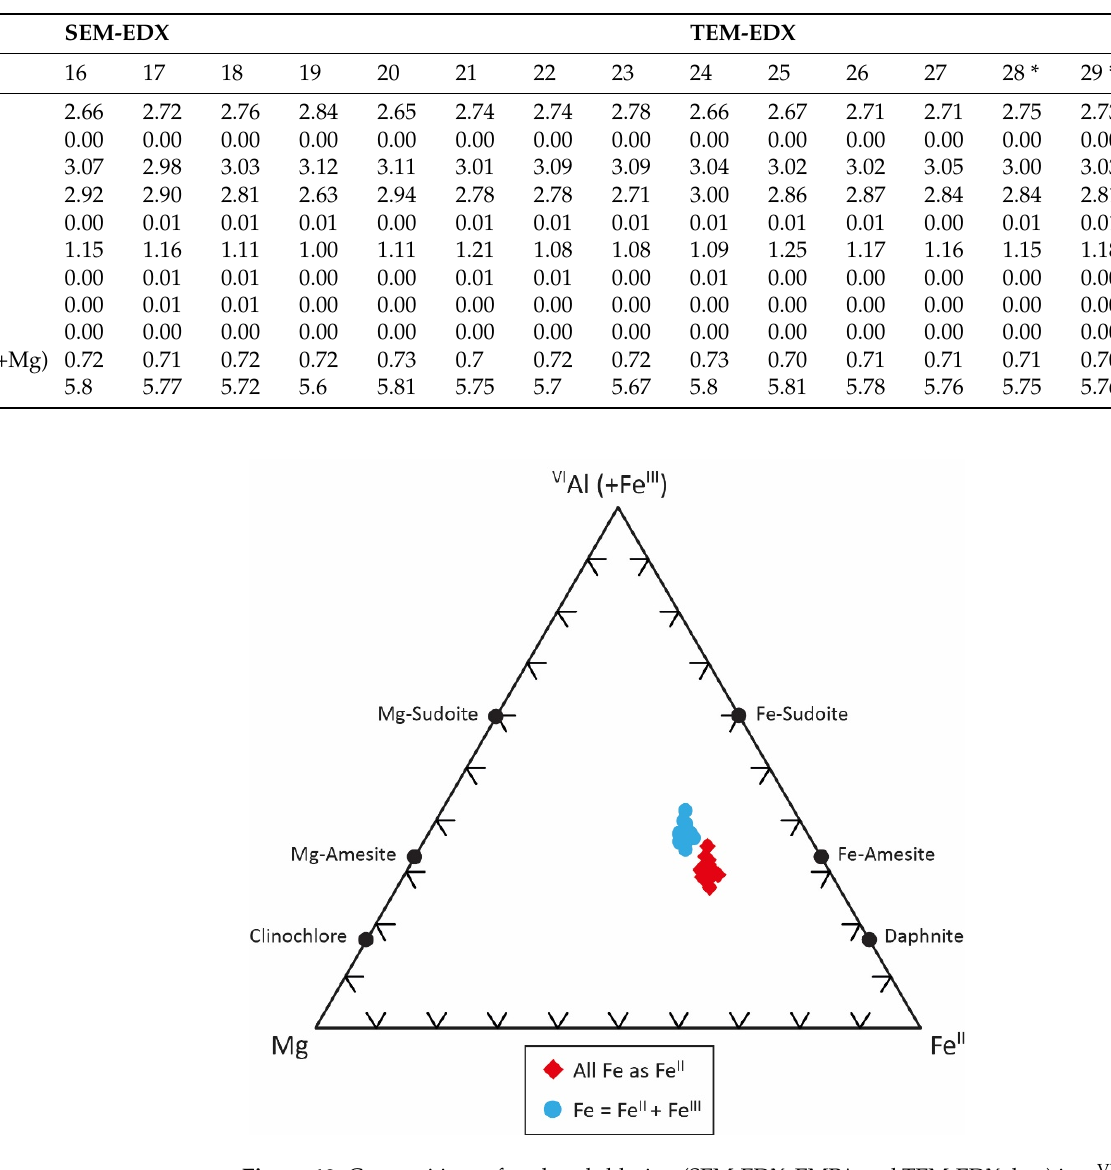
Figure 10. Compositions of analysed chlorites (SEM-EDX, EMPA and TEM-EDX data) in a VI Al-Mg-Fe II ternary diagram. Chlorite end-members are indicated.